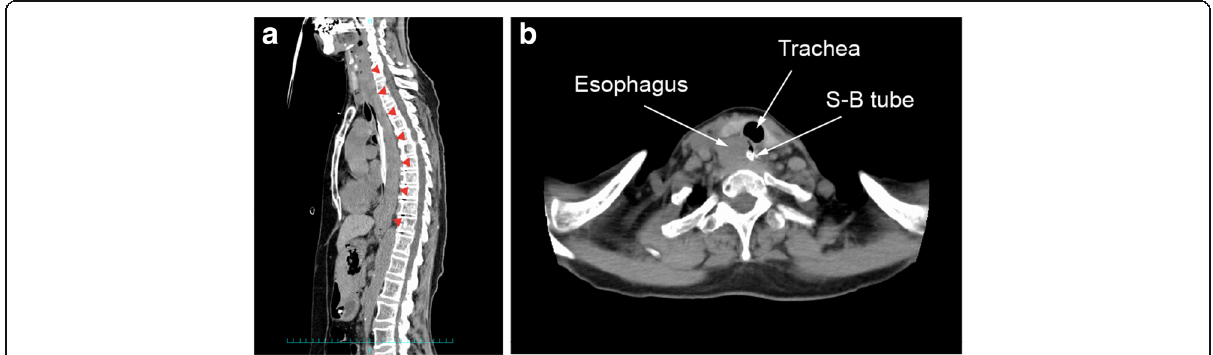
Fig. 2 Cervical and thoracic CT images after insertion of Sengstaken-Blakemore tube. a Sagittal section: the soft tissue shadow is filled and dilatation can be seen in the posterior wall over the entire length of the esophagus (red arrows), ventrally displacing the lumen. b Cross-section: the cervical esophagus is dilated, displacing the trachea toward the left